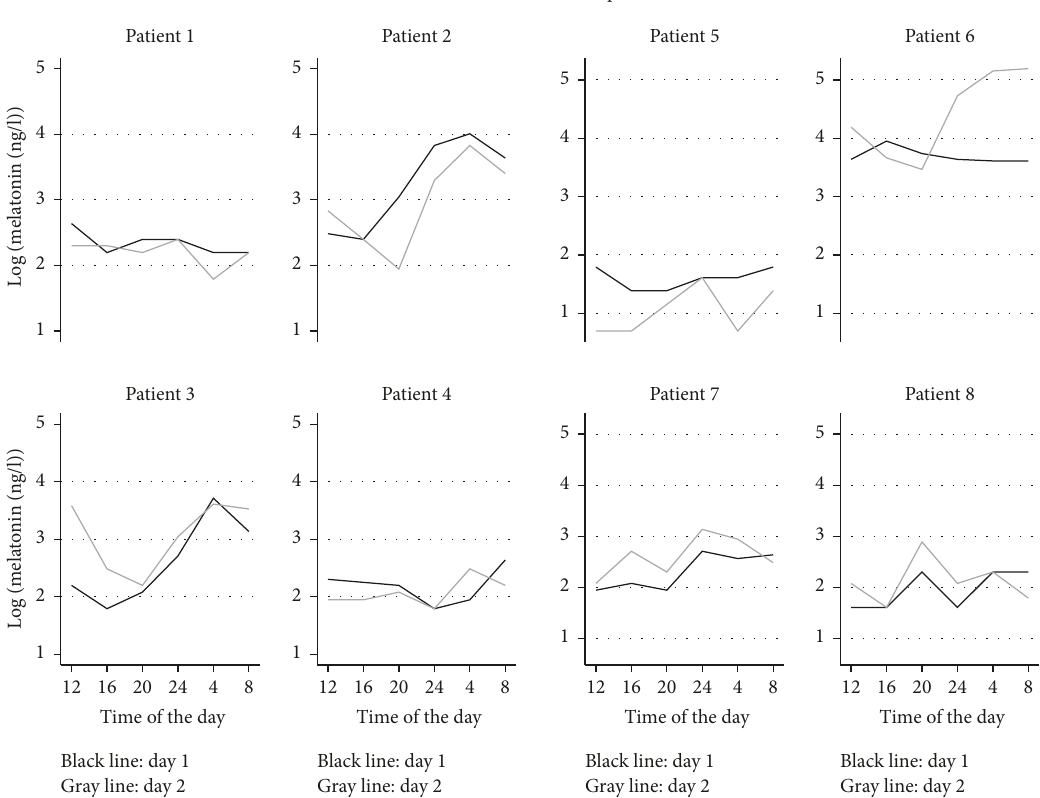
Figure 2: Individual melatonin profiles (8 patients, 2 days for each patient). The log-scale of melatonin is used to allow for appreciation of both interindividual and diurnal variation